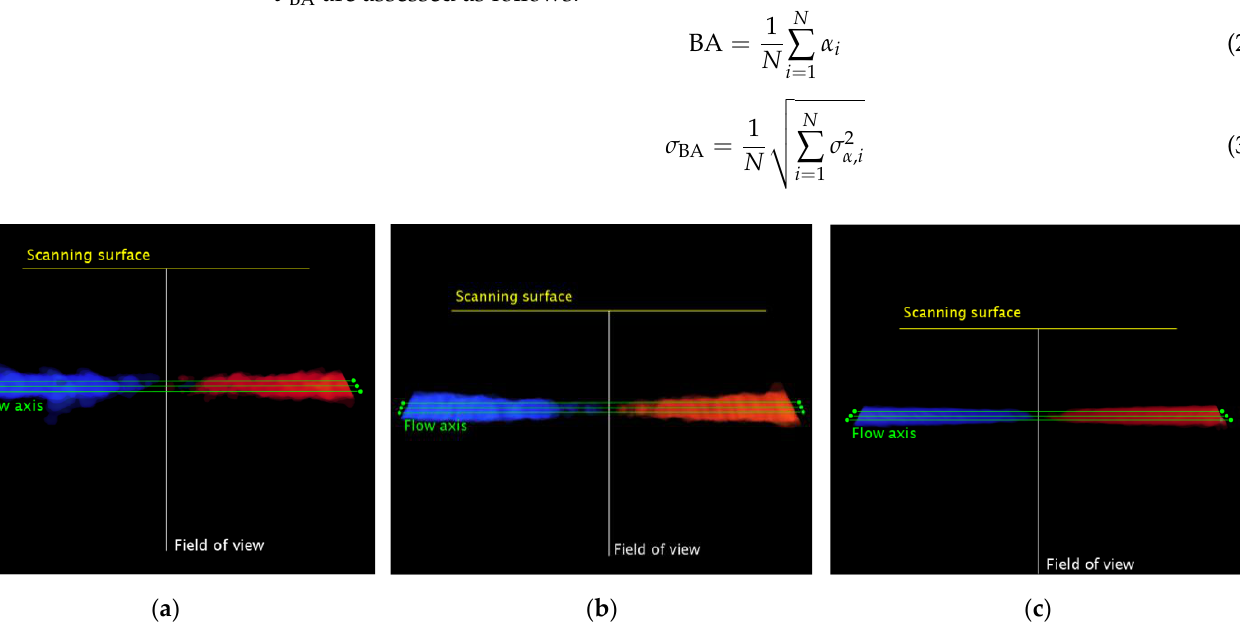
Figure 2. Flow axis placed on the i -th average image for ( a ) system one, ( b ) system two and ( c ) system three equipped with convex array probes in configuration B at medium flow rate regime Q M . Blue color indicates flow away from transducer, while red color indicates flow toward the transducer.